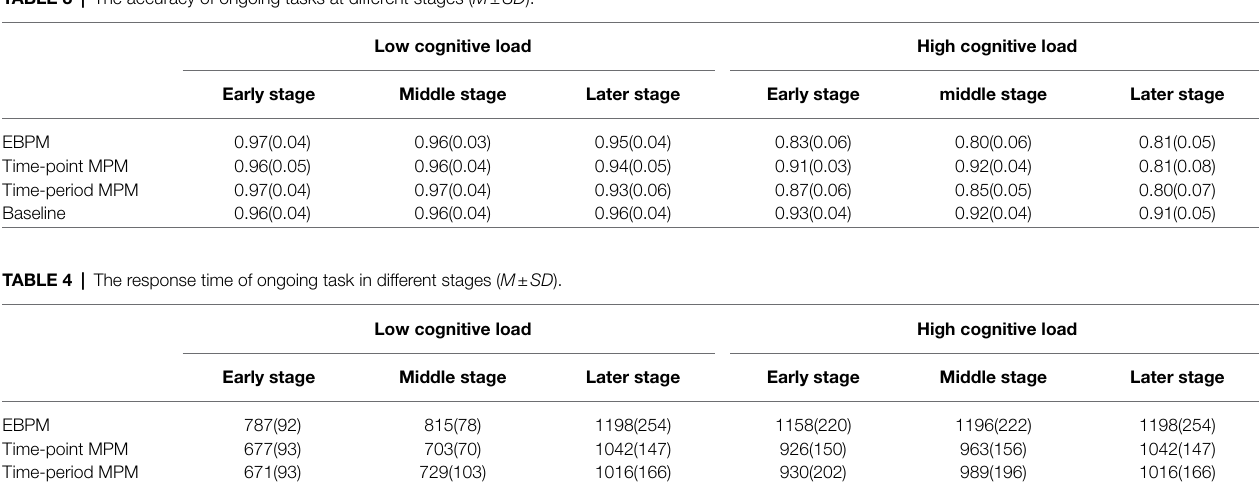
TABLE 3 | The accuracy of ongoing tasks at different stages ( M ± SD ).